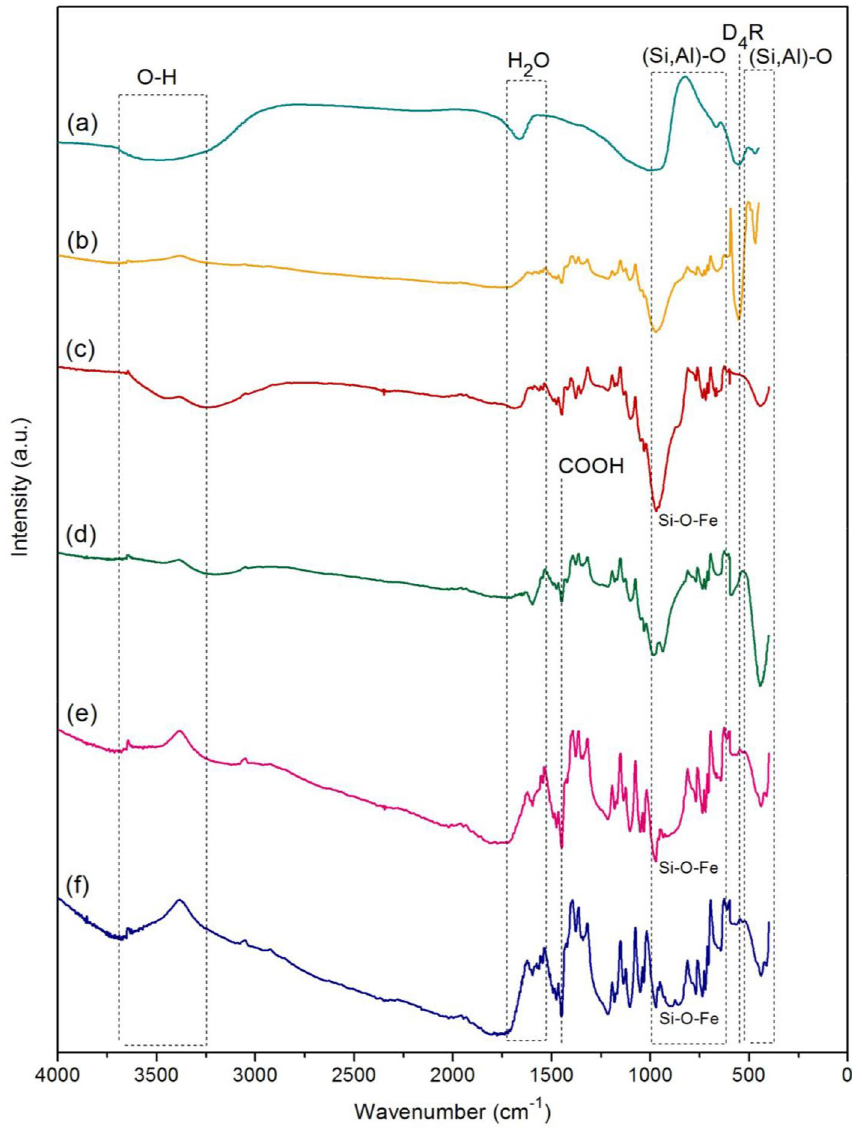
Figure 5. FT-IR spectra of (a) zeolite A standard (STD), (b) zeolite A sugarcane bagasse fly ash powder (ZB), (c) zeolite A sugarcane bagasse fly ash powder mixed iron(III) oxide-hydroxide (ZBF), (d) zeolite A sugarcane bagasse fly ash beads (ZBB), (e) zeolite A sugarcane bagasse fly ash powder mixed iron(III) oxide-hydroxide beads (ZBFB), and (f) zeolite A sugarcane bagasse fly ash beads coated iron(III) oxide-hydroxide